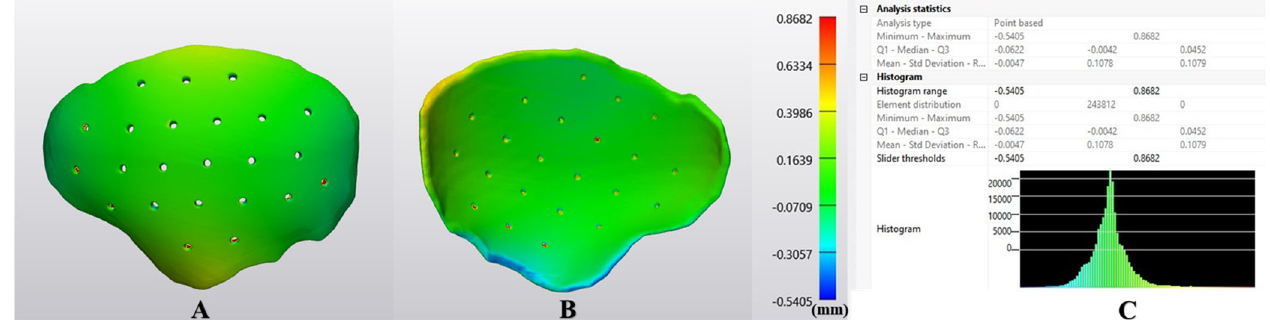
Figure 4 . Heatmap illustrating the deviations (mm) in a post-sterilized large-sized 3D-printed PEEK customized cranial implant. Visualization of ( A ) outer (squamous) surface; ( B ) inner (cerebral) surface; ( C ) descriptive analysis.